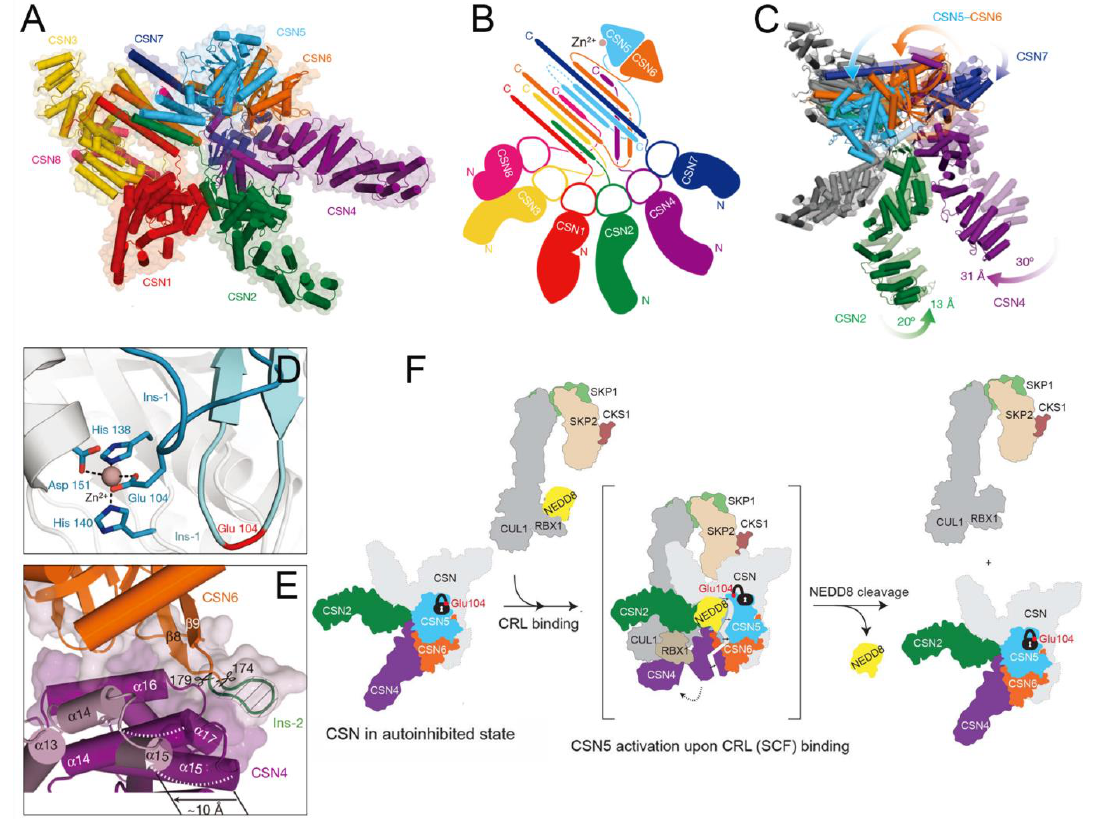
Figure 7. ( A , B ) Cryo-EM structure and flattened schematic of the CSN complex (PDB ID: 4D10). The CSN1-CSN8 are colored red, green, yellow, purple, blue, orange, deep blue, and pink, respectively. ( C ) Superimposition of CSN (PDB ID: 4D18 chains I-P, shade) and the CSN-CRL4A~N8 DDB2 (EMD- 3313) cryo-EM model. ( D ) Superposition of the Ins-1 loop with (cyan) or without (blue) an isopep- tide-linked neddylated CRLs. In the absence of substrate, the CSN isopeptidase is inhibited by the CSN5 Ins-1 loop bearing Glu 104 and separately through the CSN4 – CSN6 interface. ( E ) Removal of the CSN6 Ins-2 loop (green) disrupts the binding interface between CSN4 (purple) and CSN6 (or- ange) to impact the CSN5-CSN6 dimer. ( F ) Model of CRL-binding-induced conformational remod- eling in CSN. The CSN2, CSN4, CSN5, CSN6, RBX1, SKP2, SKP1, CKS1, and NEDD8 are colored green, purple, cyan, orange, gray, sand, light green, and brown. Panels A, B, D, E, F, and C are adapted with permission from [34,168], respectively. Copyright 2014 Springer Nature, and copy-